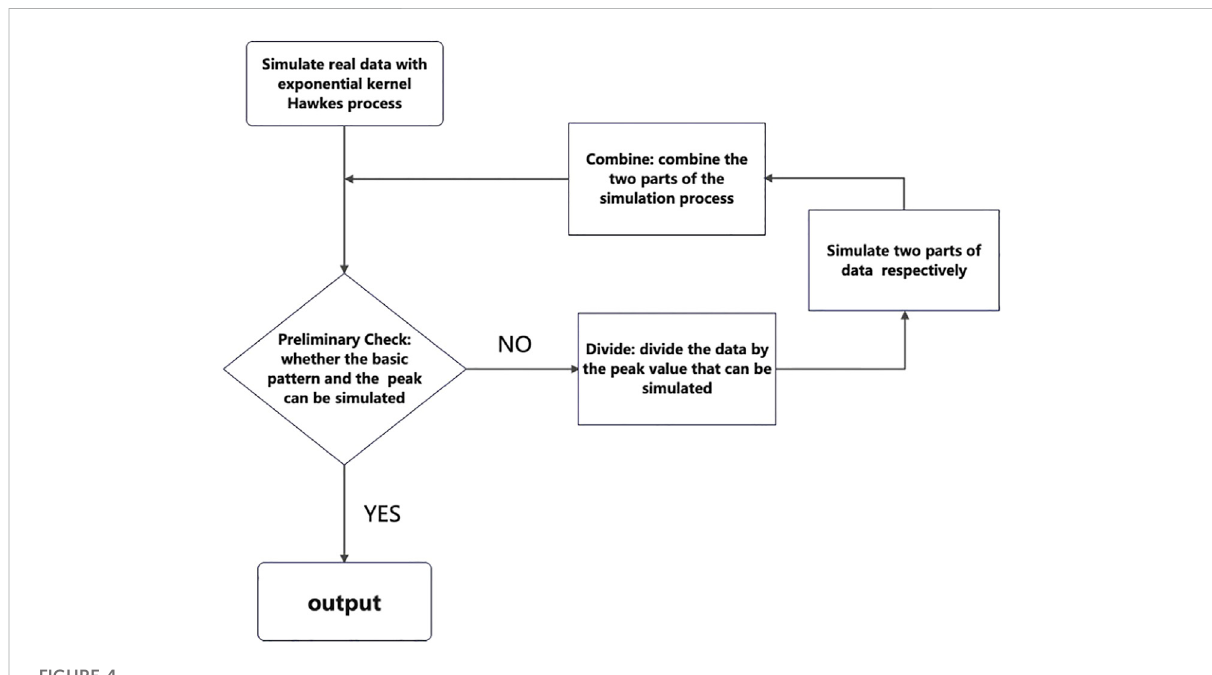
FIGURE 4 Flow chart of Algorithm